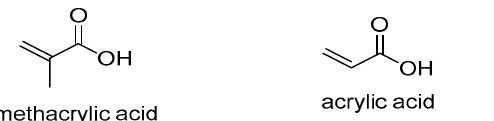
Figure 7. Structure of commonly used pendant basic groups.